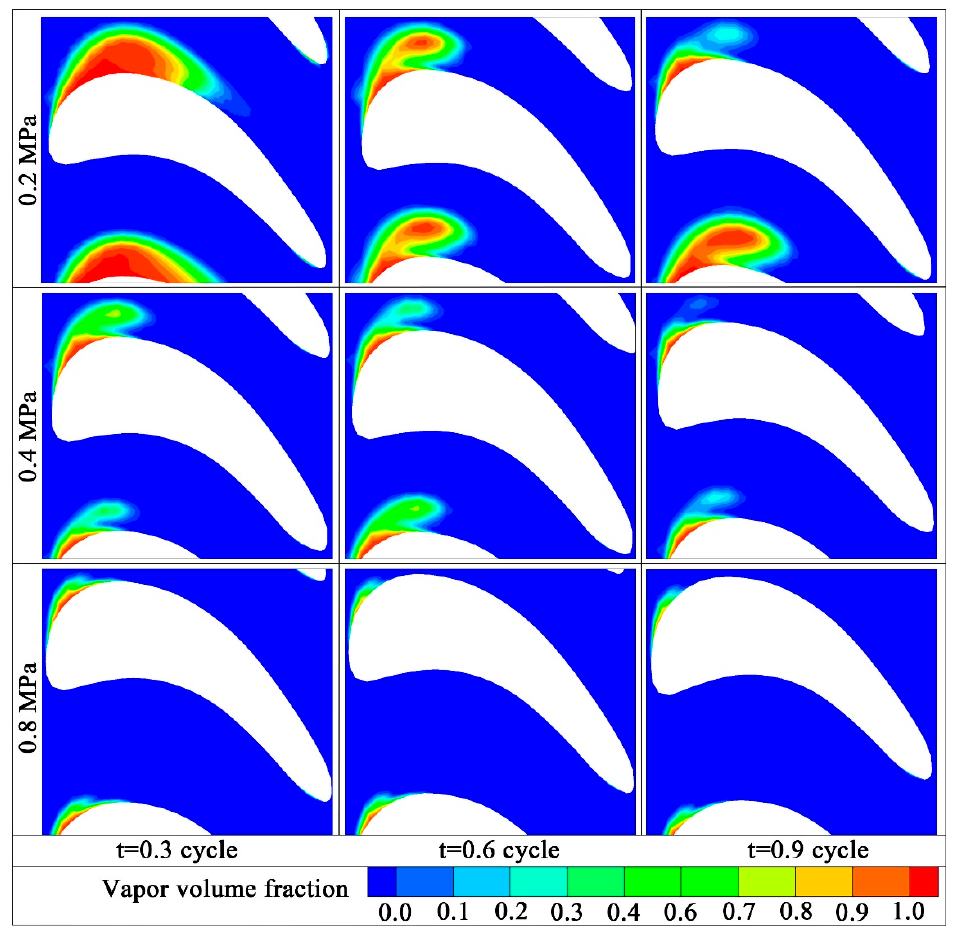
Figure 17. Vapor volume fraction distributions for one typical cycle with different backpressures ( SR = 0). ( SR = 0).